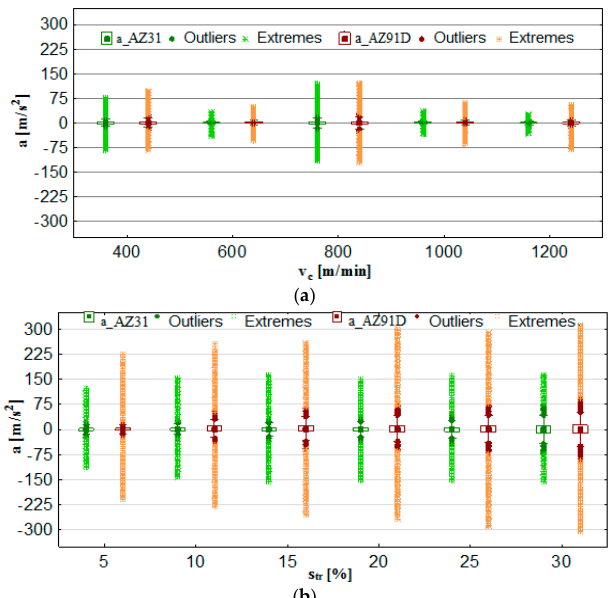
Figure 10. Effect of cutting speed and trochoidal step on vibrations acceleration in milling of magnesium alloys: ( a ) v c (f z = 0.15 mm/tooth, a p = 6 mm, s tr = 15%) and ( b ) s tr (v c = 800 m/min, f z = 0.15 mm/tooth, a p = 6 mm).